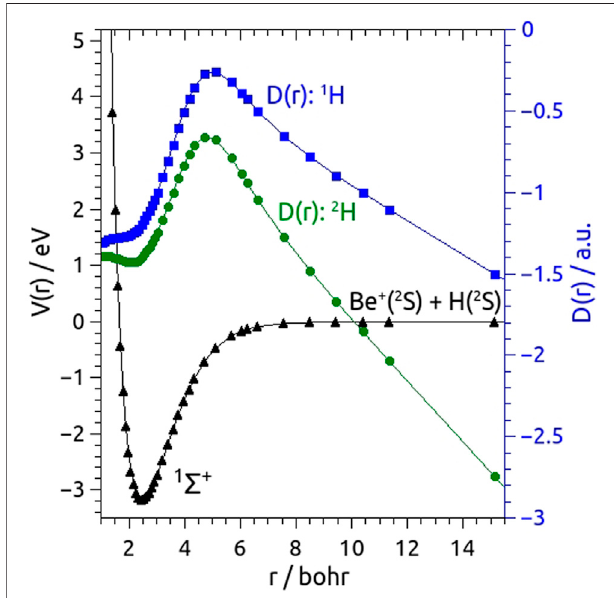
FIGURE 1 | Potential energy (black) and electric dipole curves (green and blue) for reaction (9) used in the dynamical